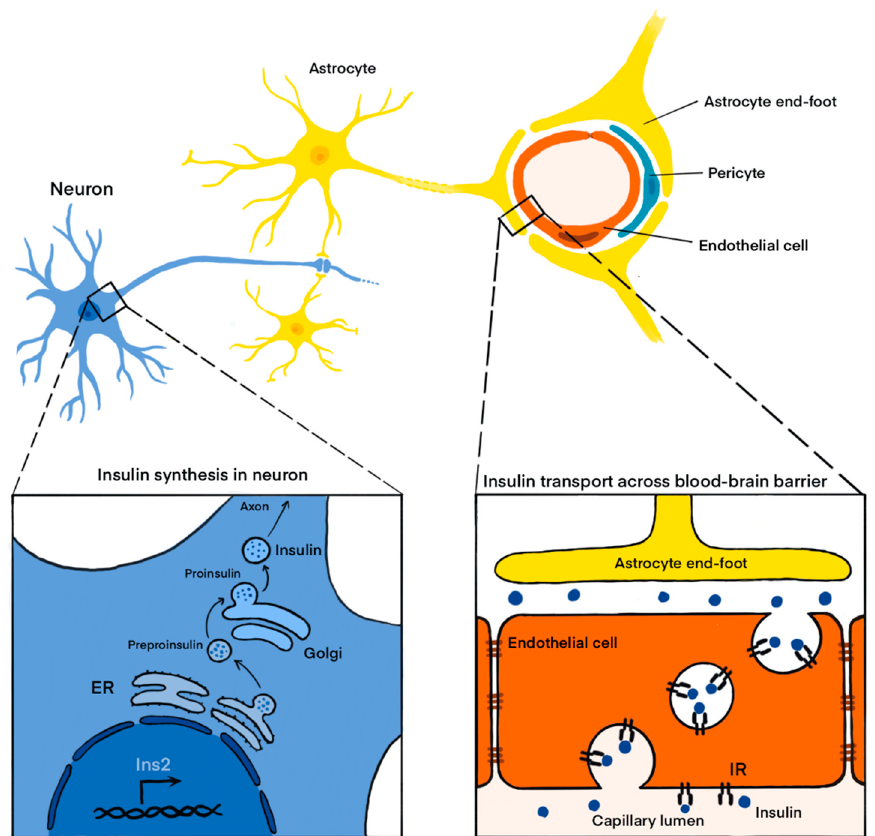
Figure 1. Insulin expression and presence in the central nervous system. Insulin synthesized in the pancreas is secreted into the systemic circulation and transported to the brain across the blood-brain barrier by receptor-mediated transcytosis. In addition, insulin is synthesized in neurons. Ins2 —insulin 2; IR—insulin receptor; ER—endoplasmic reticulum.